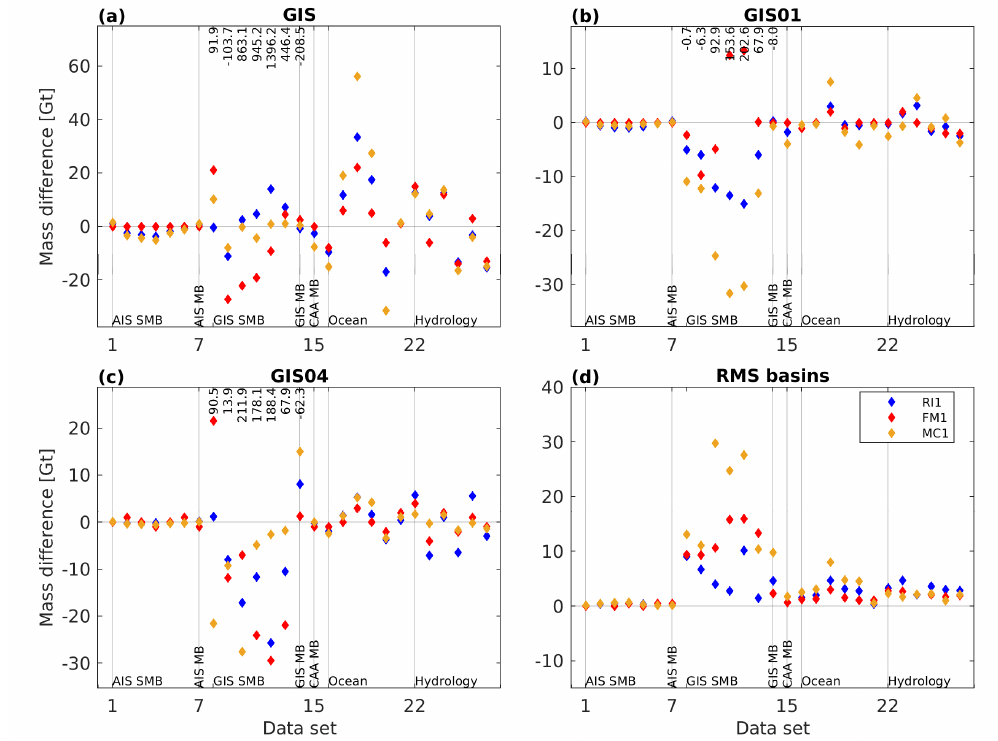
Figure 12. Differences between mass change estimates derived from different synthetic data sets and the corresponding true mass change for ( a ) the GIS as well as drainage basins ( b ) GIS01 and ( c ) GIS04. True (non-zero) mass changes are indicated by numbers at the top margin (unit: gigatons). ( d ) RMS of the differences for all drainage basins